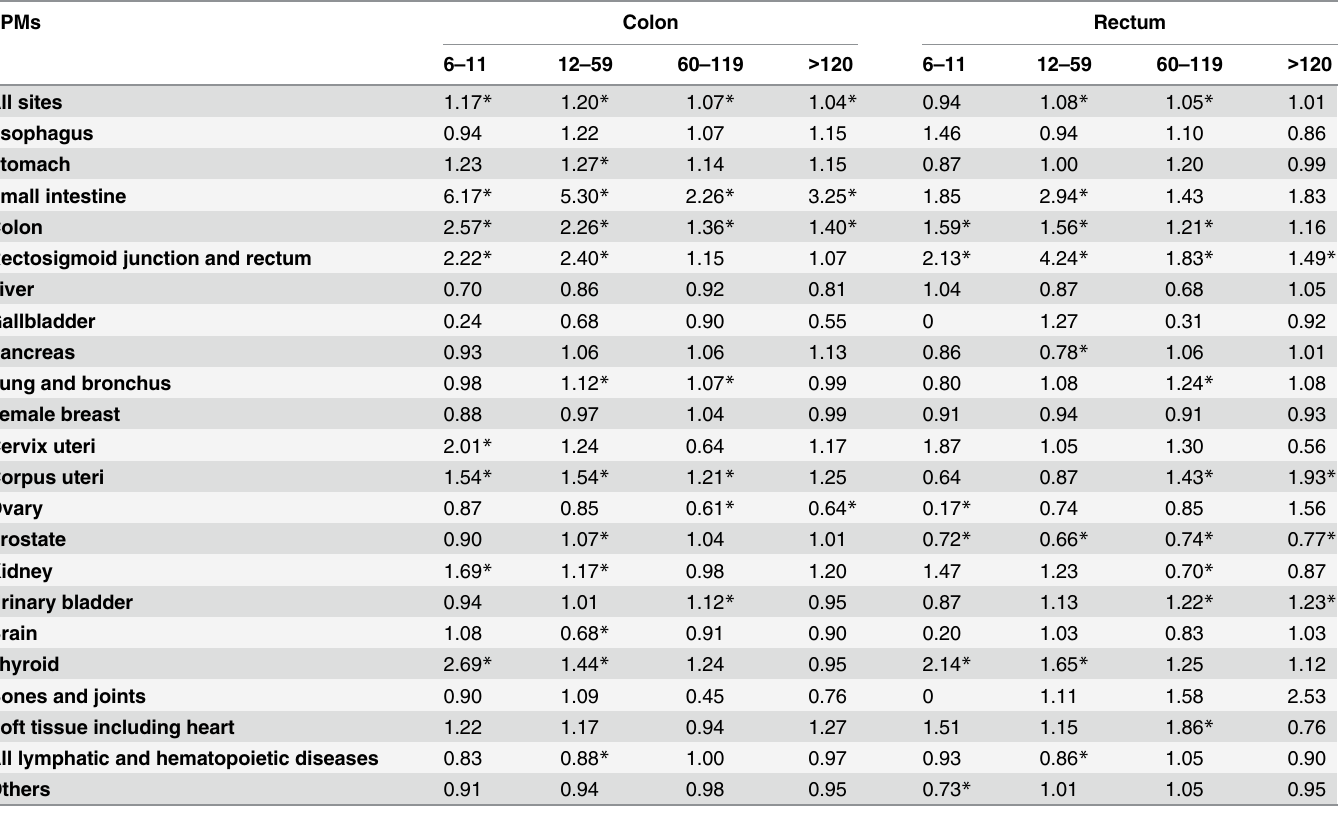
Table 7. SIRs of SPMs in colon and rectal cancer patients, by